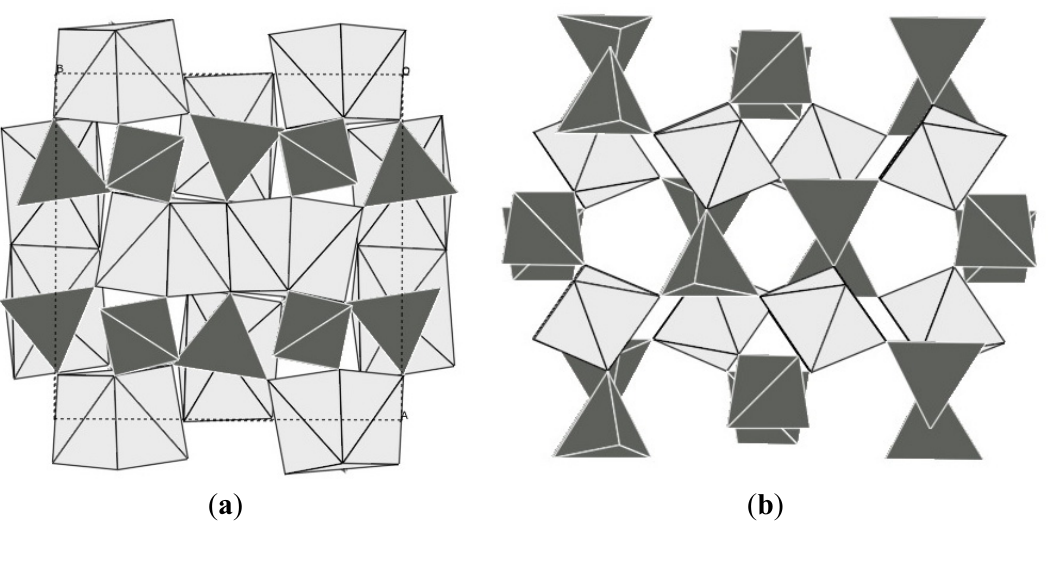
Figure 6. Crystal structures of ( a ) Pba2-Y polyhedral; dark: MoO number of yttrium is increased, and the polyhedra share